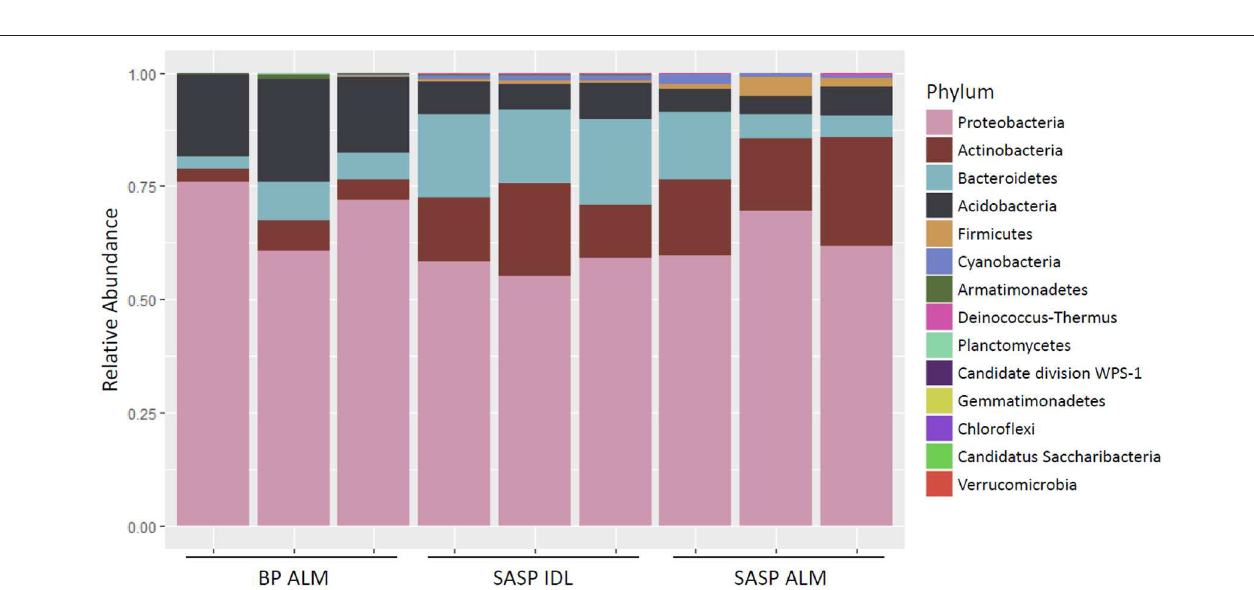
FIGURE 11 | Relative abundance of microorganism in each replicate at the phylum level. for samples from Berthoud Pass (merged layer BP ALM), and Swamp Angel Study Plot (SASP, individual deposited layers, IDL and all layers merged, ALM).